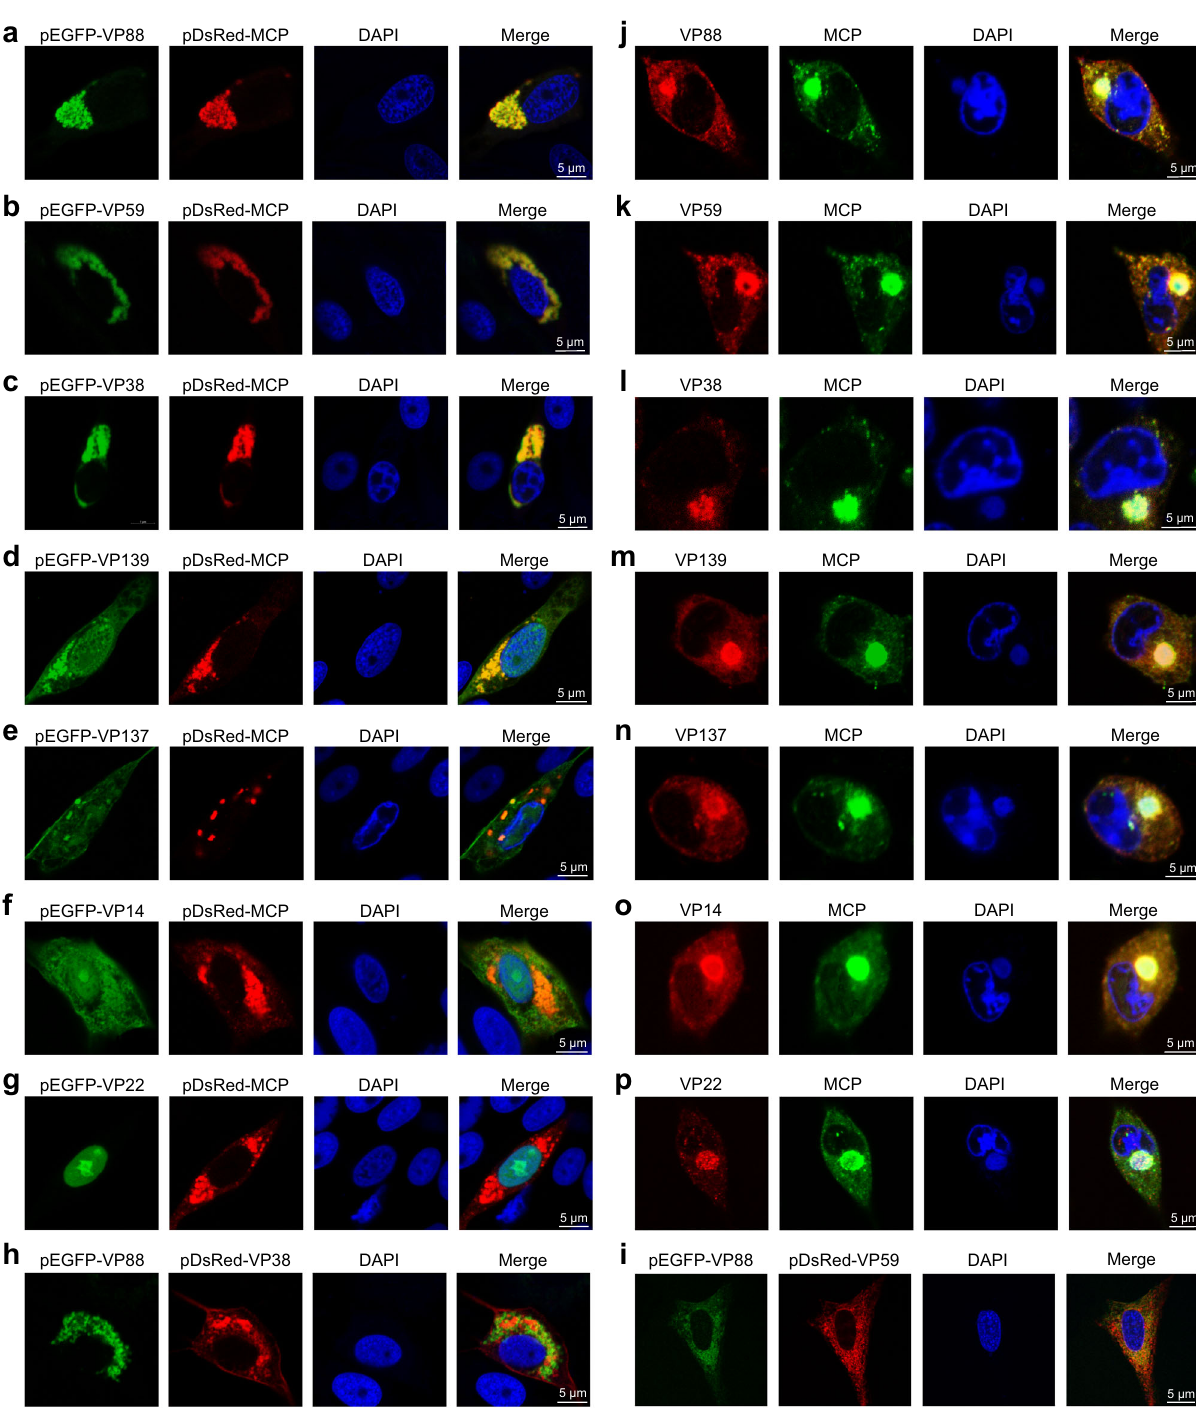
( k ),VP38( l ),VP139( m ),VP137( n ),VP14( o ),orVP22( p )andtheMCPdeterminedby immuno fl uorescence assays for the EAGS cells infected with authentic SGIV for 24h. After fi xation and permeabilization, cells were incubated with a mouse mAb against SGIV MCP and rabbit polyclonal antibody against SGIV VP88 (VP59, VP38, VP139, VP137, VP14, or VP22) for 1h. Anti-rabbit Alexa Fluor 555 (red) secondary antibody and anti-mouse Alexa Fluor 488 (green) secondary antibody were used. The VF, a spherical structure close to the nucleus, was stained with DAPI. Data are representative of three independent